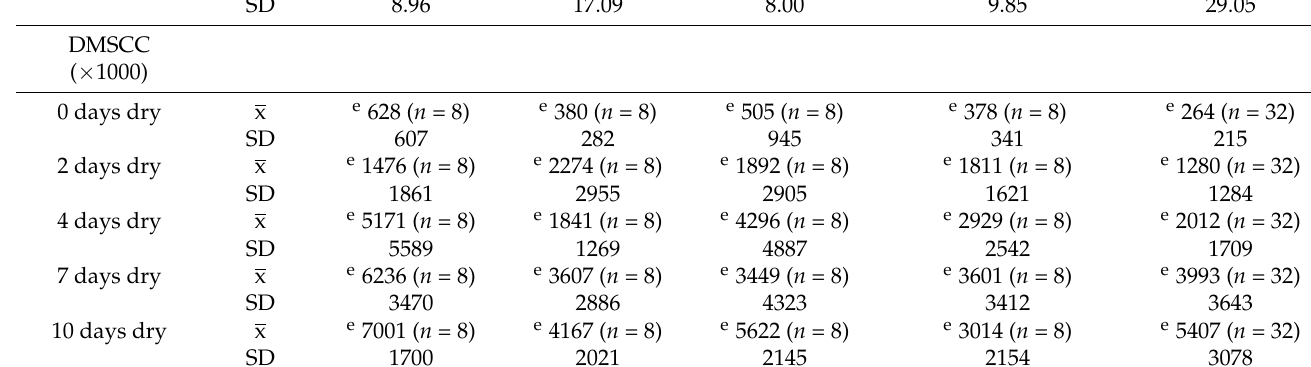
Casein Casein Hydrolysate + Casein Hydrolysate + Casein Dry Cow Treatment + Hydrolysate + Dry Cow Hydrolysate Teat Sealant Teat Sealant Treatment